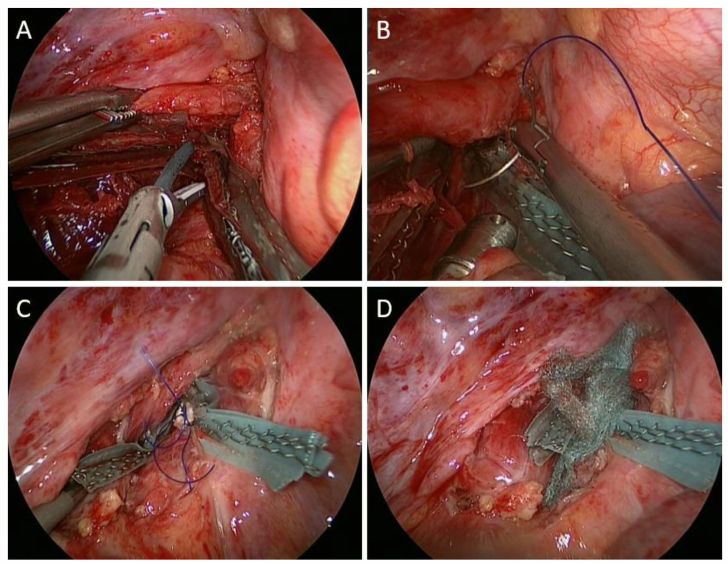
Figure 3. Intraoperative views of the patient (first part). ( A ) The fistulous tract between the esophagus and the trachea was exposed. (Blue asterisk: fistula) ( B ) The fistula was dissected using a right angle clamp. (Blue asterisk: fistula) ( C ) Using a stapler buttressed with a PGA sheet to divide the fistula; ( D ) The fistula was divided appropriately; and the split ends of the fistula are shown (black arrows). The distal end of the fistula was dissected by Harmonic scalpel scissor thoroughly (Figure 4A), and the further suture reinforcement for the split ends of the trachea with a Prolene 3-0 was accomplished (Figure 4B,C). After air-tightness testing showed no air leakage from both split ends of the trachea and the esophagus, more PGA sheets were packed over the space between both divided ends (Figure 4D).